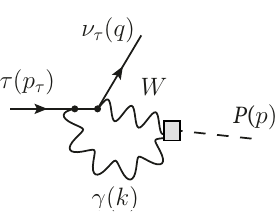
Figure 3 . Feynman diagram corresponding to the virtual-photon structure-dependent (vSD) contributions to τ → Pν decays. The gray shaded box stands for the structure-dependent vector τ and axial hadronic